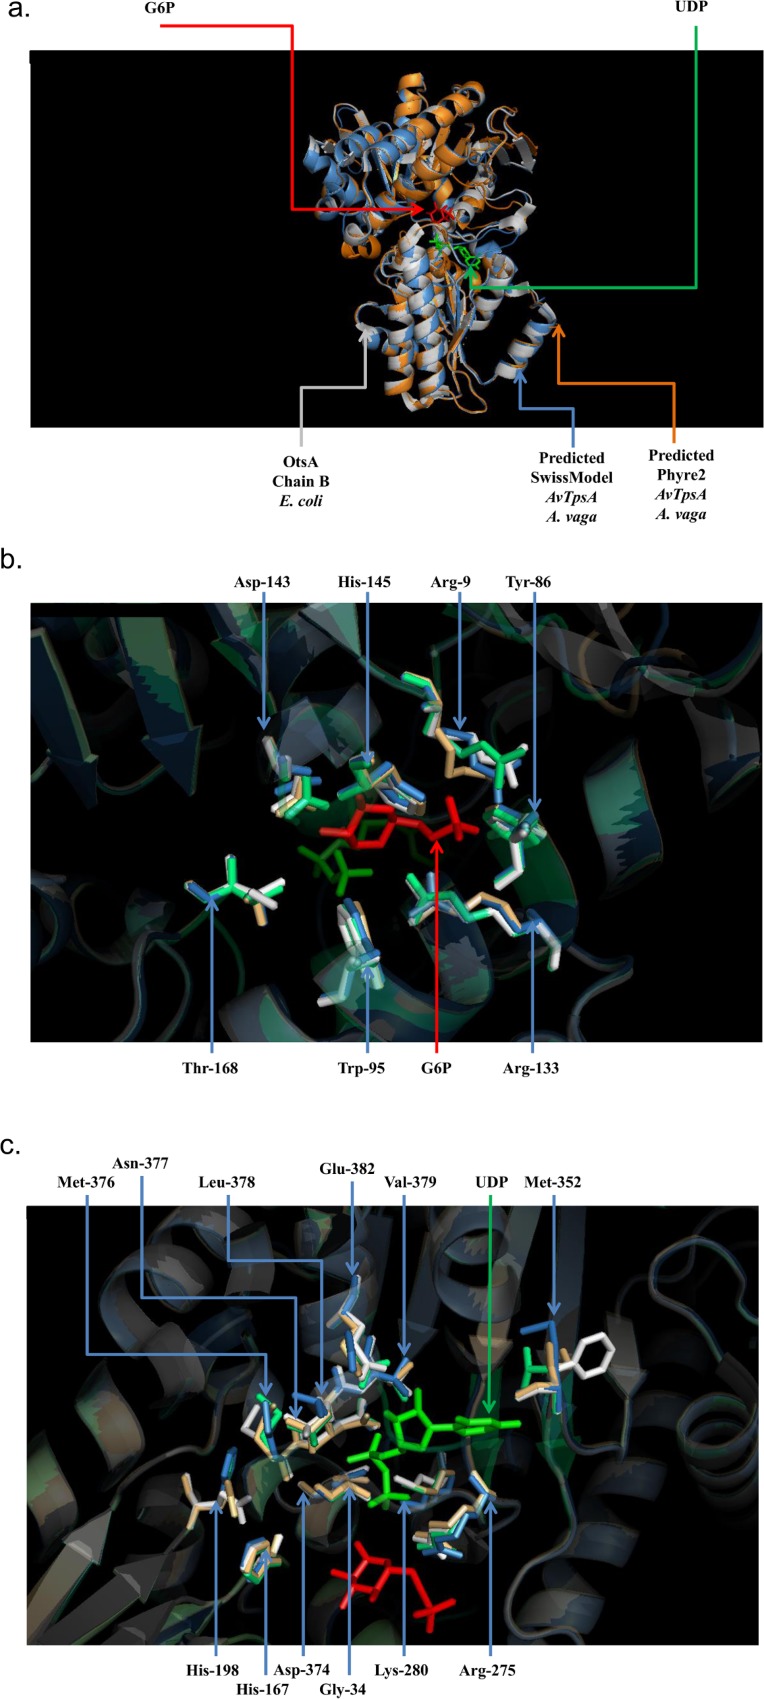
(a.) 3D alignment of the OtsA chain B crystal structure obtained for E. coli (white) with the two protein structures of TPS1 modeled using SWISS-MODEL (light blue) and PHYRE2 (orange).UDP (green) and G6P (red) are localized as observed in the OtsA crystal structure. (b.) Close-up on the conserved sites involved in the binding of G6P (red). The residues of the E. coli OtsA are shown in white and those of the AvTpsA predicted using SWISS-MODEL in light blue. SwissModel TPS1 A. thaliana (light green) and SwissModel predicted TPS1 P. brassicacea (gold) are also displayed in order to compare their topologies. (c.) Close-up on the conserved sites related to the binding of UPD (green). The residues are labeled based on the 3D structure of AvTpsA predicted using SWISS-MODEL.